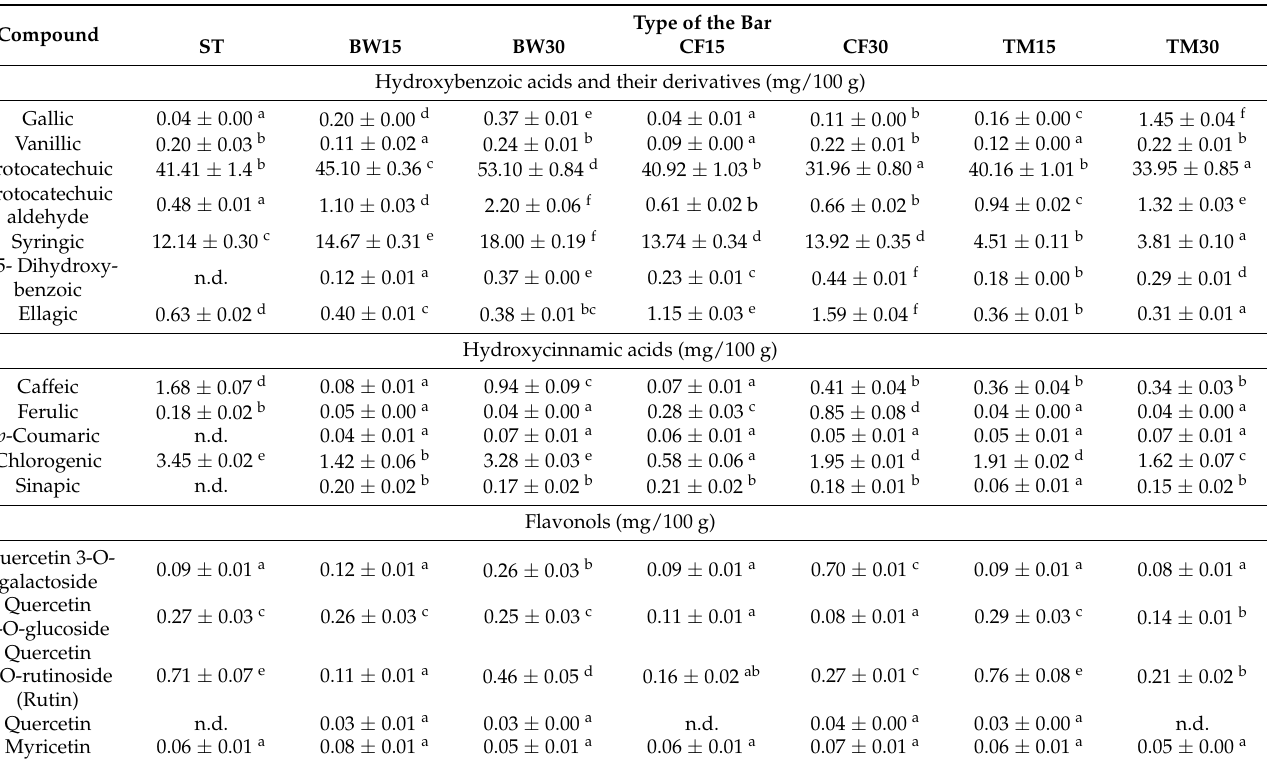
Table 2. Profile of phenolic compounds of edible insect